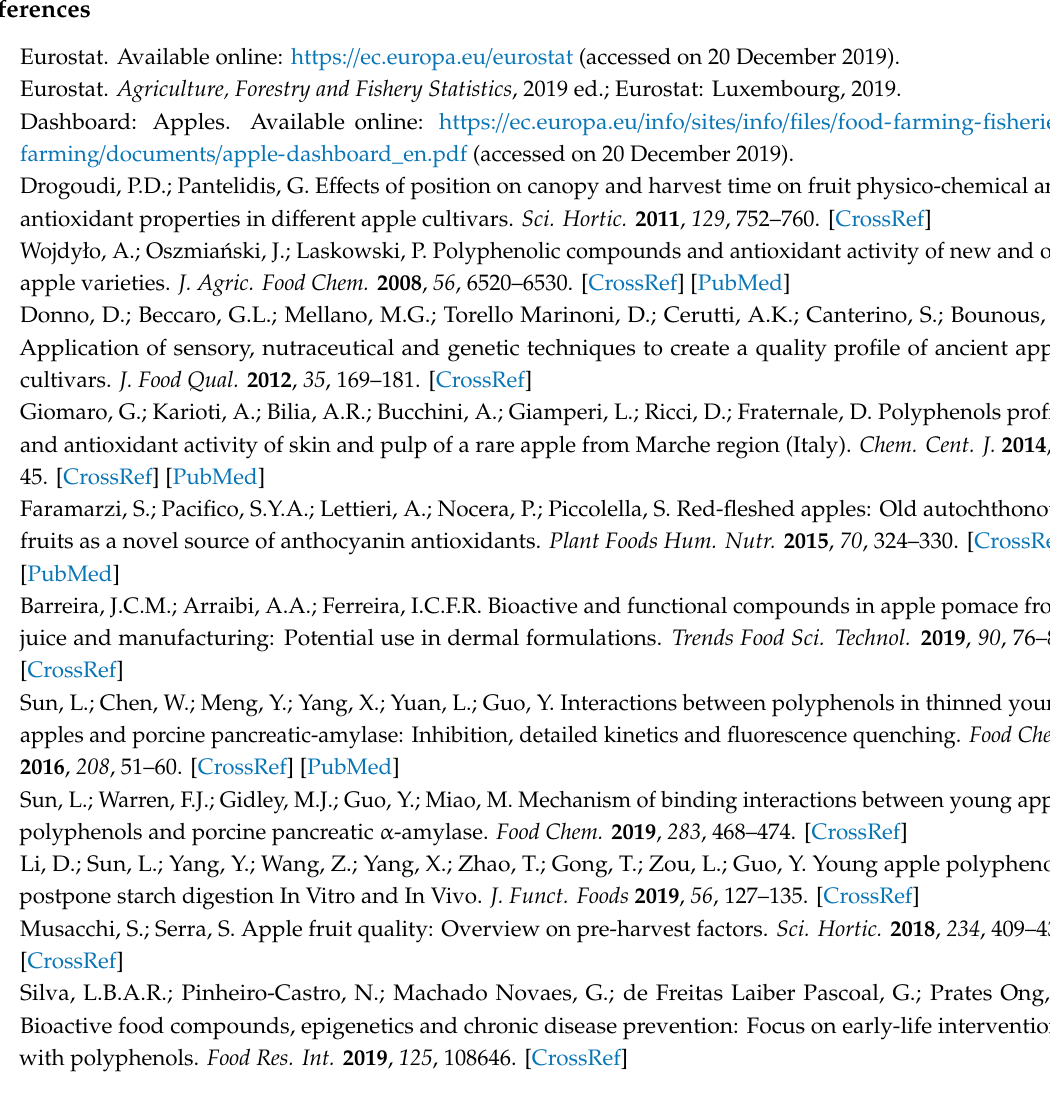
Figure S1: Histogram of basic external fruit quality characteristics with marked commercial apple variety (‘Idared’), Figure S2: Histogram of basic internal fruit quality characteristics with marked commercial apple variety (‘Idared’), Table S1: Pearson correlation coe ffi cient for internal and external fruit characteristics and seed characteristics. Author